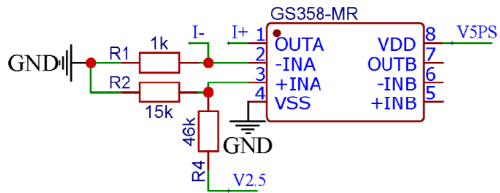
Figure 4. Schematic diagram of the constant current source circuit.